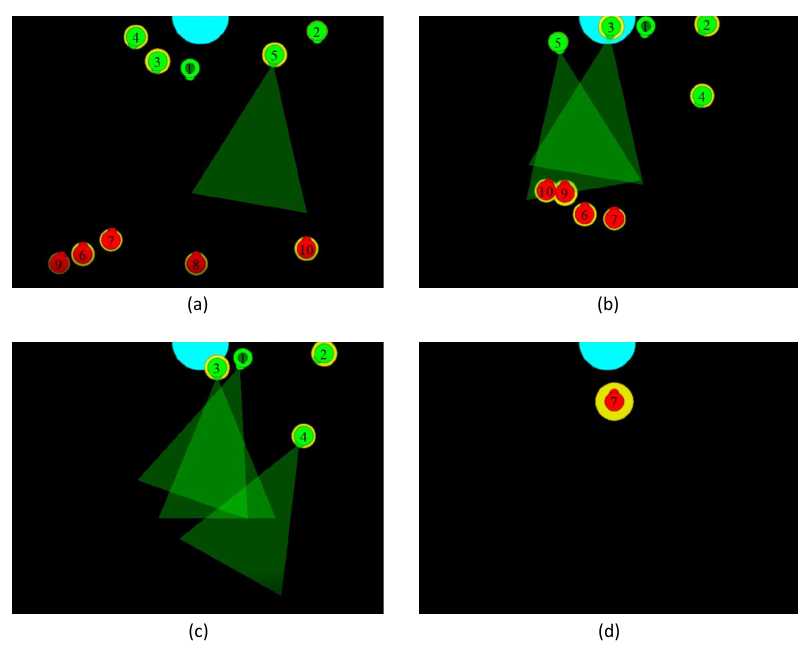
Figure A2. Simulation results of Open AI gym: ( a ) start mission at random point, ( b ) red and green team performed their mission, ( c ) green team defended the fort, ( d ) red team reached the